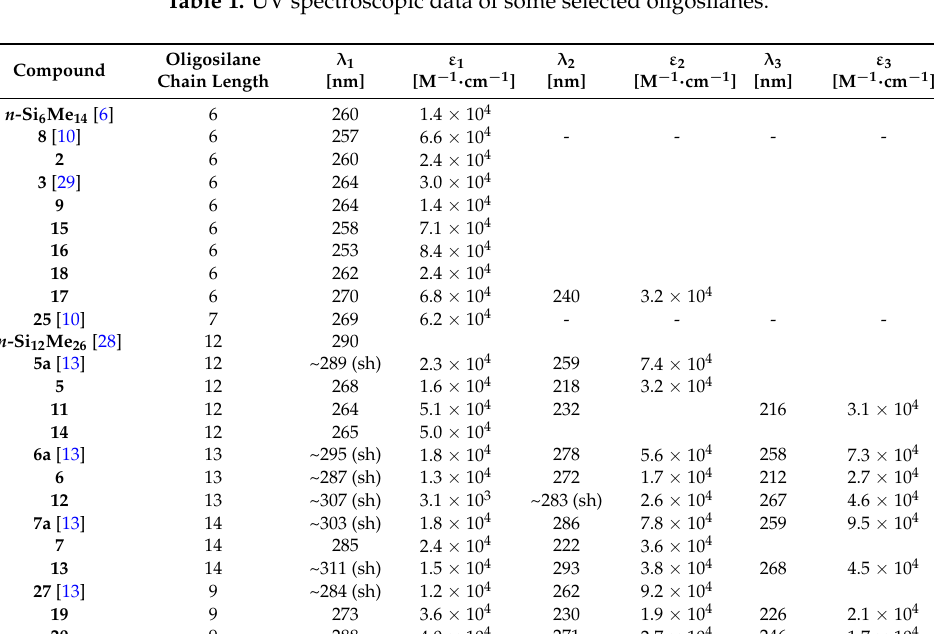
Figure 5. Comparison of the UV spectra of differently substituted hexasilanes. Table 1. UV spectroscopic data of some selected oligosilanes.